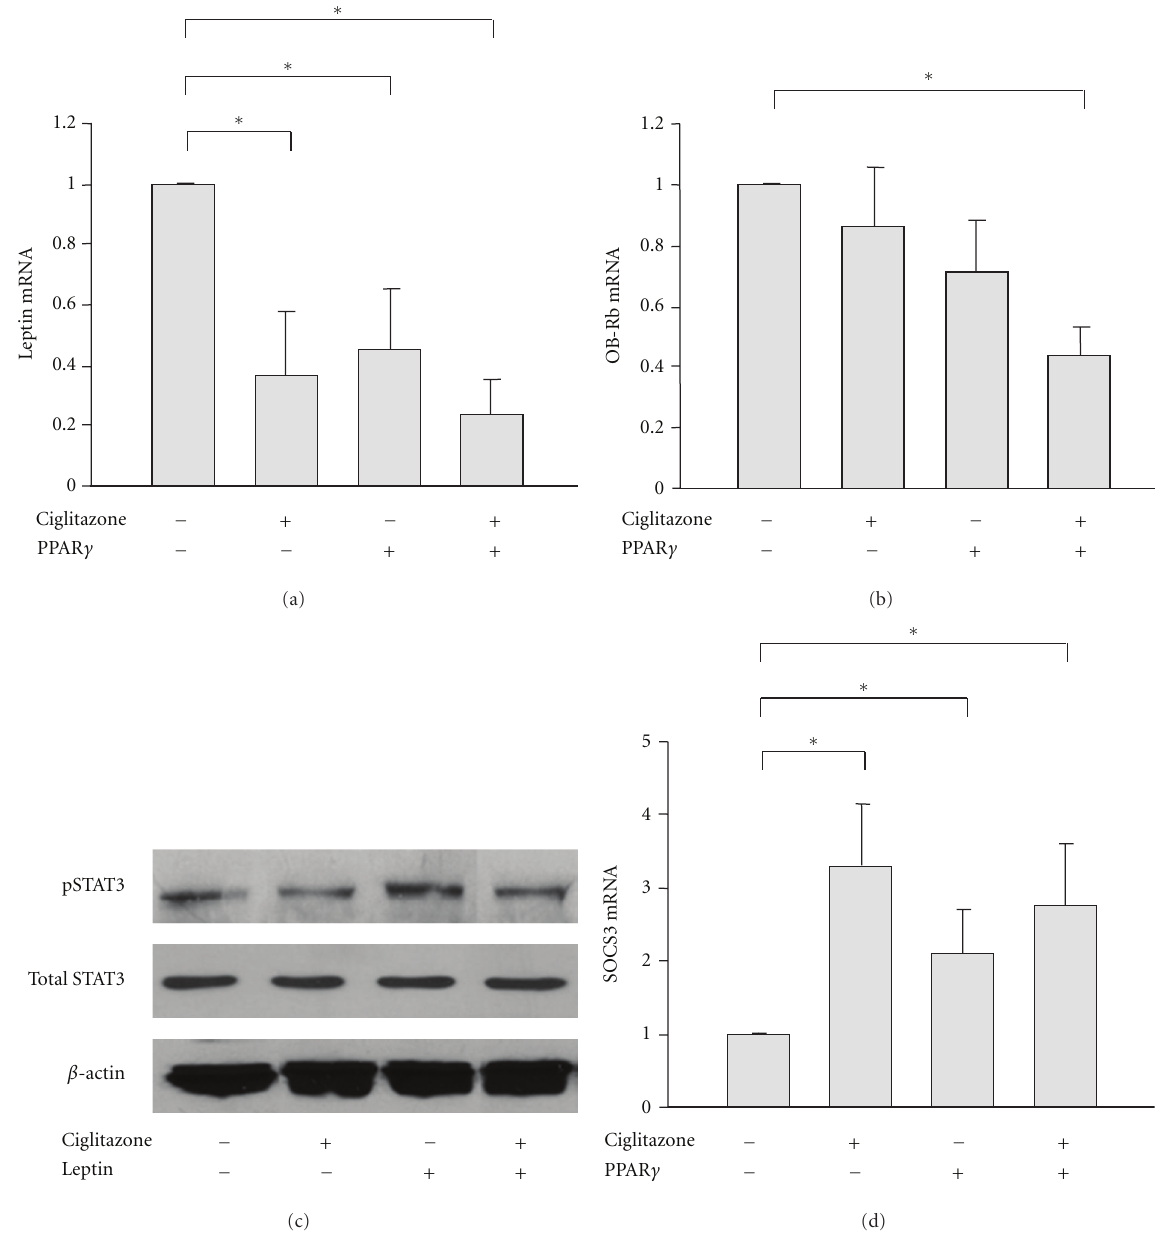
Figure 4: . Leptin signaling is regulated by PPAR γ activation in growth plate chondrocytes. (a) and (b) Real-time RT-PCR analysis of gene expression of leptin ligand (a) and leptin receptor Ob-Rb (b) in growth plate chondrocytes treated with ciglitazone and/or Ad-PPAR γ for 5 days. ∗ P < 0 . 05 versus the expression in control cells. (c) Immunoblotting analysis of the levels of total and phosphorylated STAT3 in the lysates of chondrocytes treated with ciglitazone and/or leptin for 5 days. (d) SOCS3 mRNA expression in growth plate chondrocytes treated with ciglitazone and/or Ad-PPAR γ for 5 days. ∗ P < 0 . 05 versus the expression in control